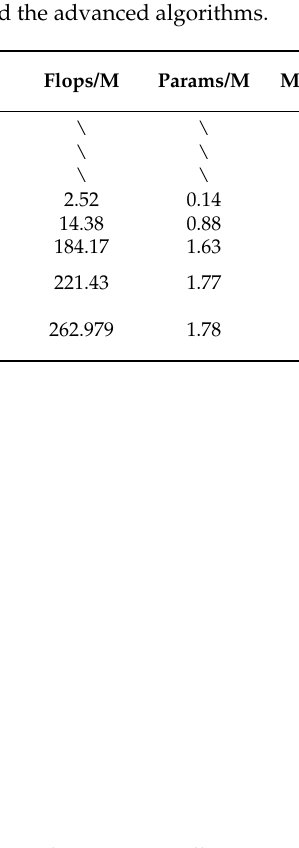
Figure 23. The performance of multiple comparison methods in the average well.